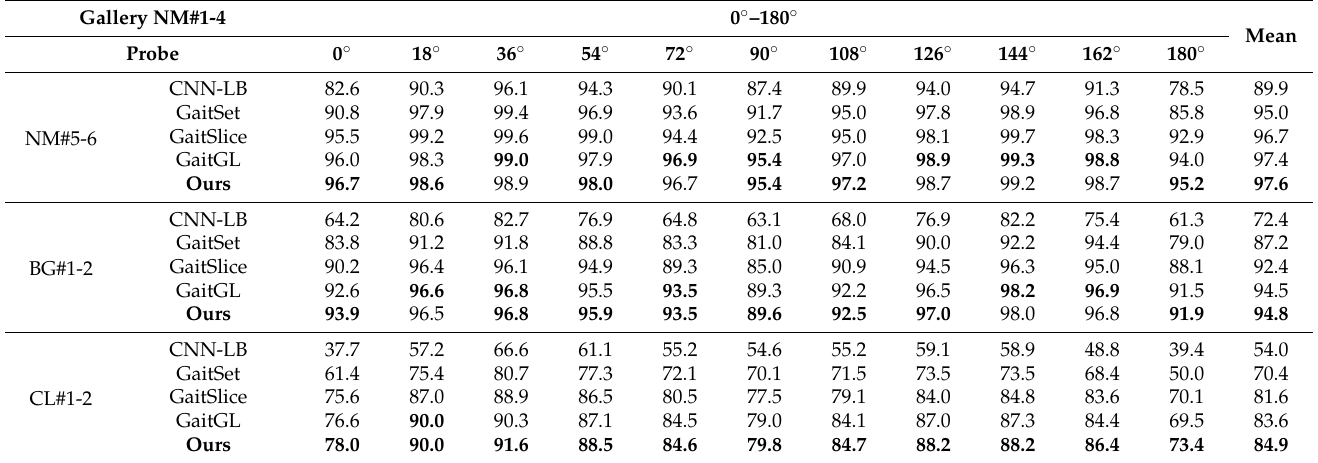
Table 2. Averaged rank-1 accuracies on CASIA-B under LT setting, excluding identical-view cases.